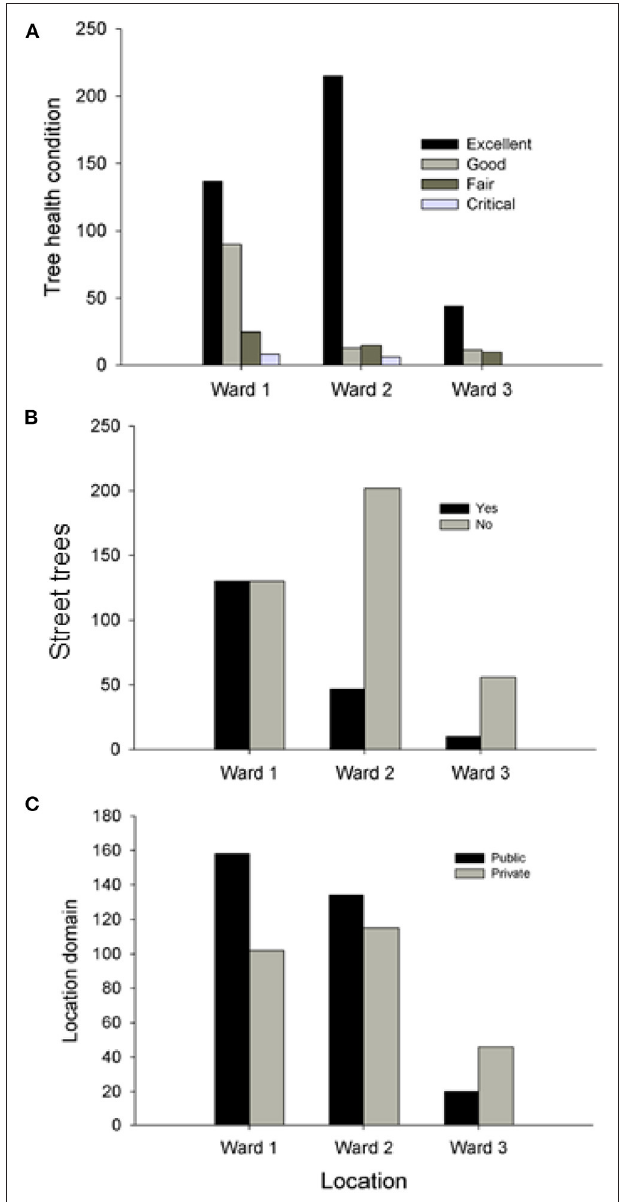
FIGURE 6 | Differences among the three wards in the National District area of Santo Domingo, Dominican Republic in the frequency distribution of trees according to: (A) health condition categories ( X 2 > 70, p < 0.001); (B) functional locality (streets vs. no streets) ( X 2 = 66.39, df = 2, p < 0.001); and (C) urban domain (public vs. private) ( X 2 = 19.7, df = 2, p <